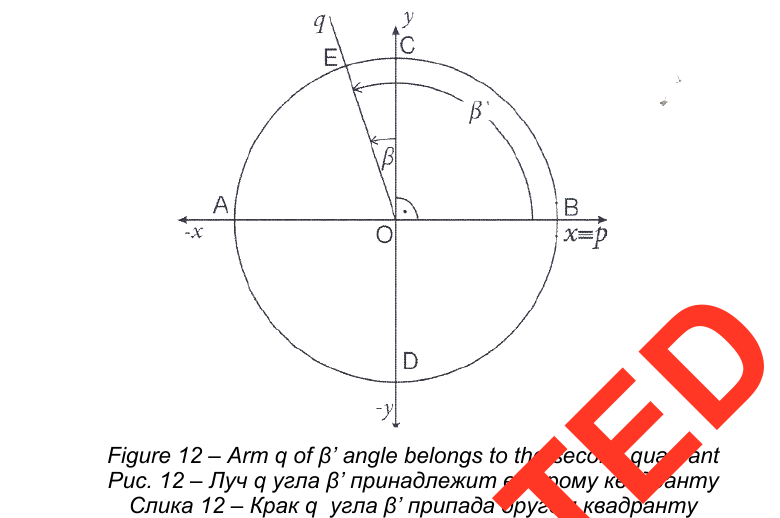
Figure 12 – Arm q of β ’ angle belongs to the second quadrant Рис . 12 – Луч q угла β ’ принадлежит второму квадранту Слика 12 – Крак q угла β ’ припада другом квадранту